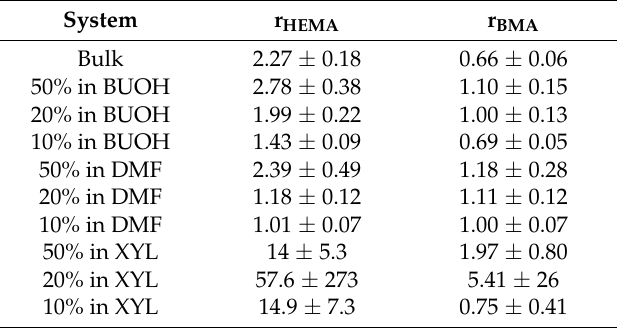
Figure 3. BMA/HEMA Mayo Lewis plots of HEMA molar composition in the copolymer (F HEMA ) vs. comonomer mixture (f HEMA ), grouped by vol% monomer in the mixture: ( a ) 50 vol% monomer in solvent; ( b ) 20 vol% monomer in solvent; and ( c ) 10 vol% monomer in solvent. Lines are the best-fit representation of experimental data points according to the terminal model using reactivity ratios summarized in Table 2. Each plot contains the curve for the bulk system (solid line), and the F HEMA = f HEMA diagonal (dashed line) indicating equal comonomer reactivity. BUOH— n -butanol; DMF—dimethylformamide; XYL—xylene. Table 2. Reactivity ratios determined by terminal model fit to data, with 95% confidence intervals. “System” refers to the vol% of comonomer in the monomer/solvent mixture. BUOH— n -butanol; DMF—dimethylformamide;